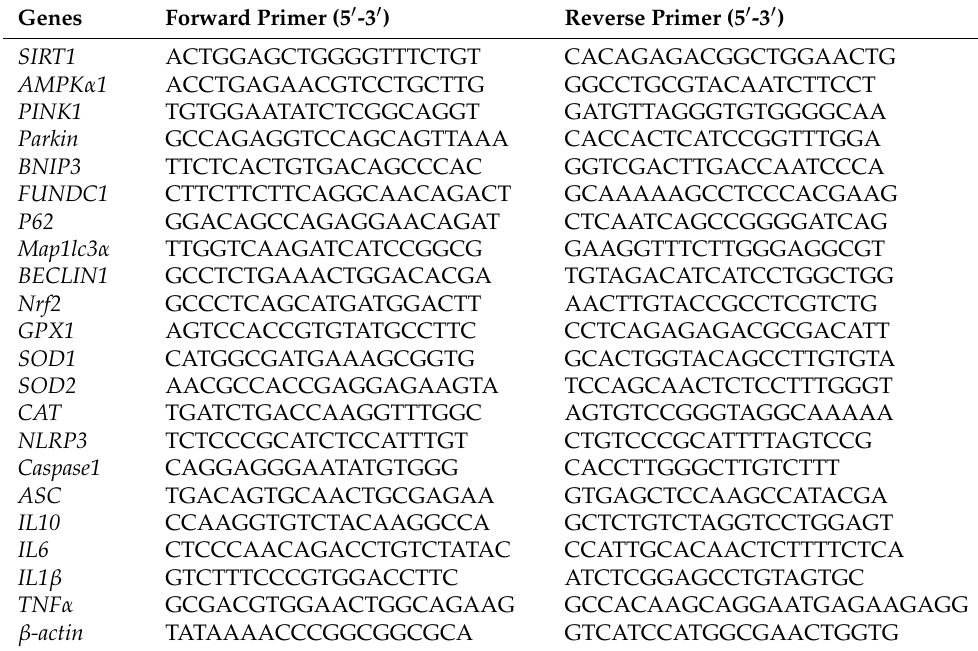
Table 1. Sequences for real-time PCR primers. Genes Forward Primer (5 (cid:48) -3 (cid:48)